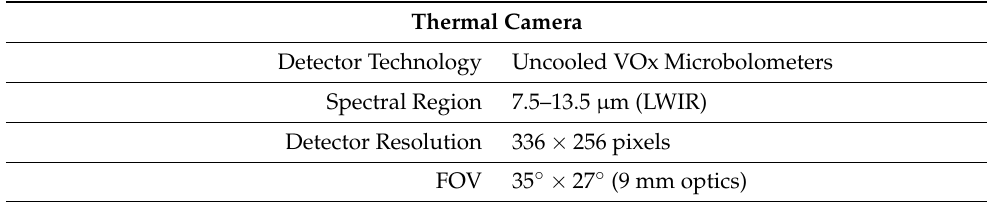
Table 2. Instrument